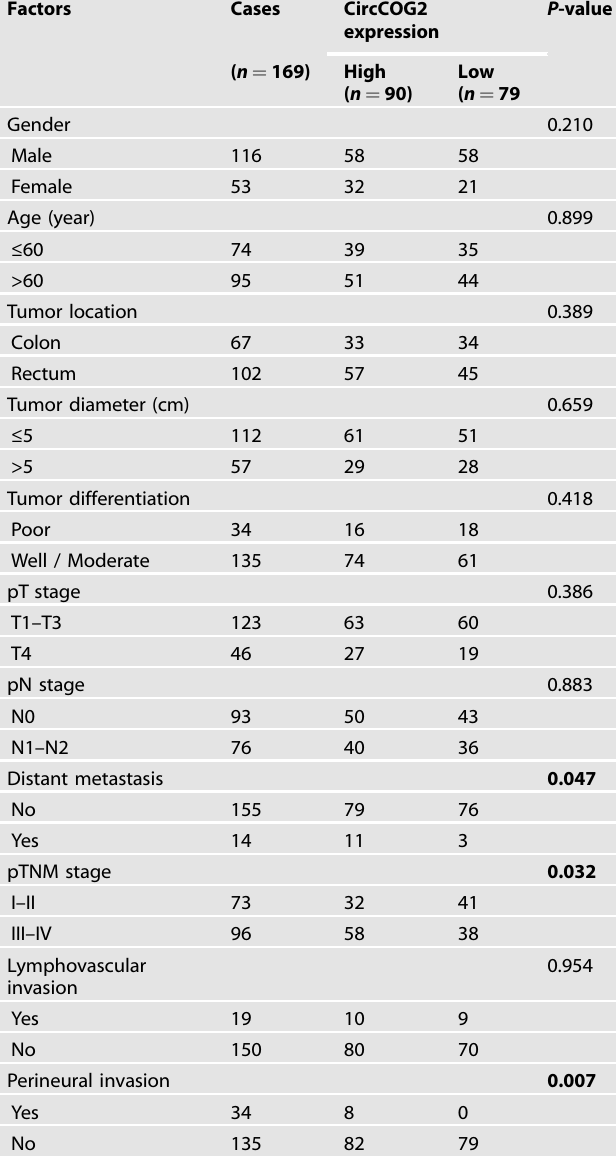
Table 1. CircCOG2 expression levels with clinicopathological features derived from CRC patient